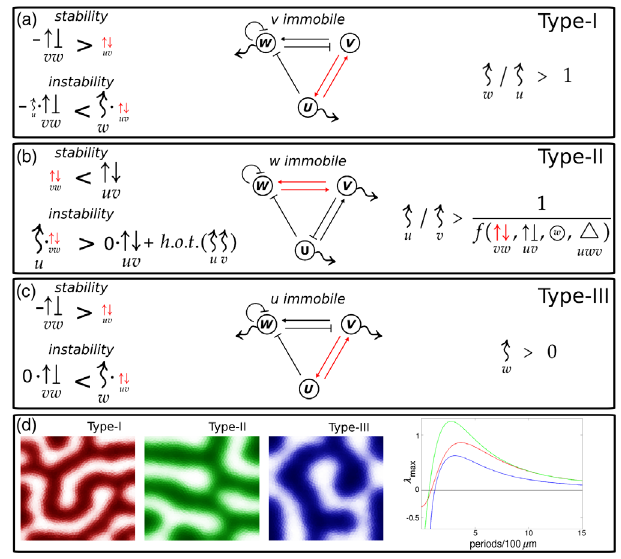
FIG. 3. (a) – (c) Permutation of the immobile node in the topology of Fig. 2 results in a Turing network of each type. In each panel, stability and instability requirements are shown on the left, with diffusion constraints on the right. (d) Patterns and dispersion relationships of type I, II, III are qualitatively